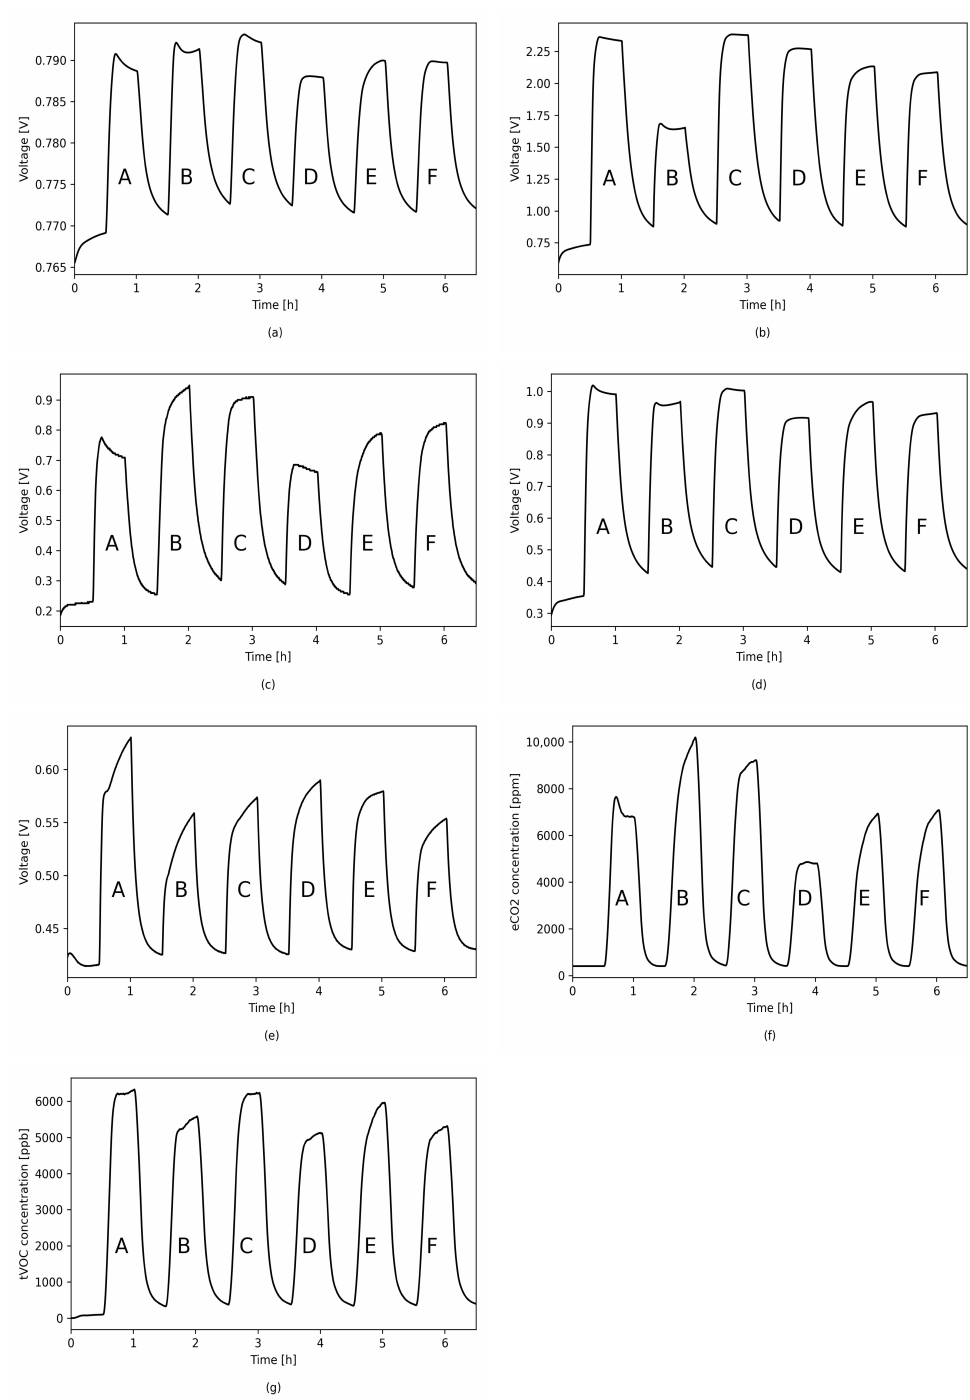
Figure 8. Sensors’ responses to different simulated mixtures in 0% RH. A. 1.5 ppm acetone, 2.5 ppm ethanol, 1 ppm propane; B. 1.5 ppm acetone, 1 ppm ethanol, 2.5 ppm ethylbenzene; C. 1.5 ppm acetone, 1.5 ppm ethanol, 1 ppm ethylbenzene, 1 ppm propane; D. 1.5 ppm acetone, 1.5 ppm ethanol, 1 ppm propane; E. 1.5 ppm acetone, 1.5 ppm ethanol, 0.5 ppm ethylbenzene, 0.5 ppm propane; F. 1.5 ppm acetone, 1 ppm ethanol, 1 ppm ethylbenzene, 0.5 ppm propane; ( a ) TGS1820; ( b )